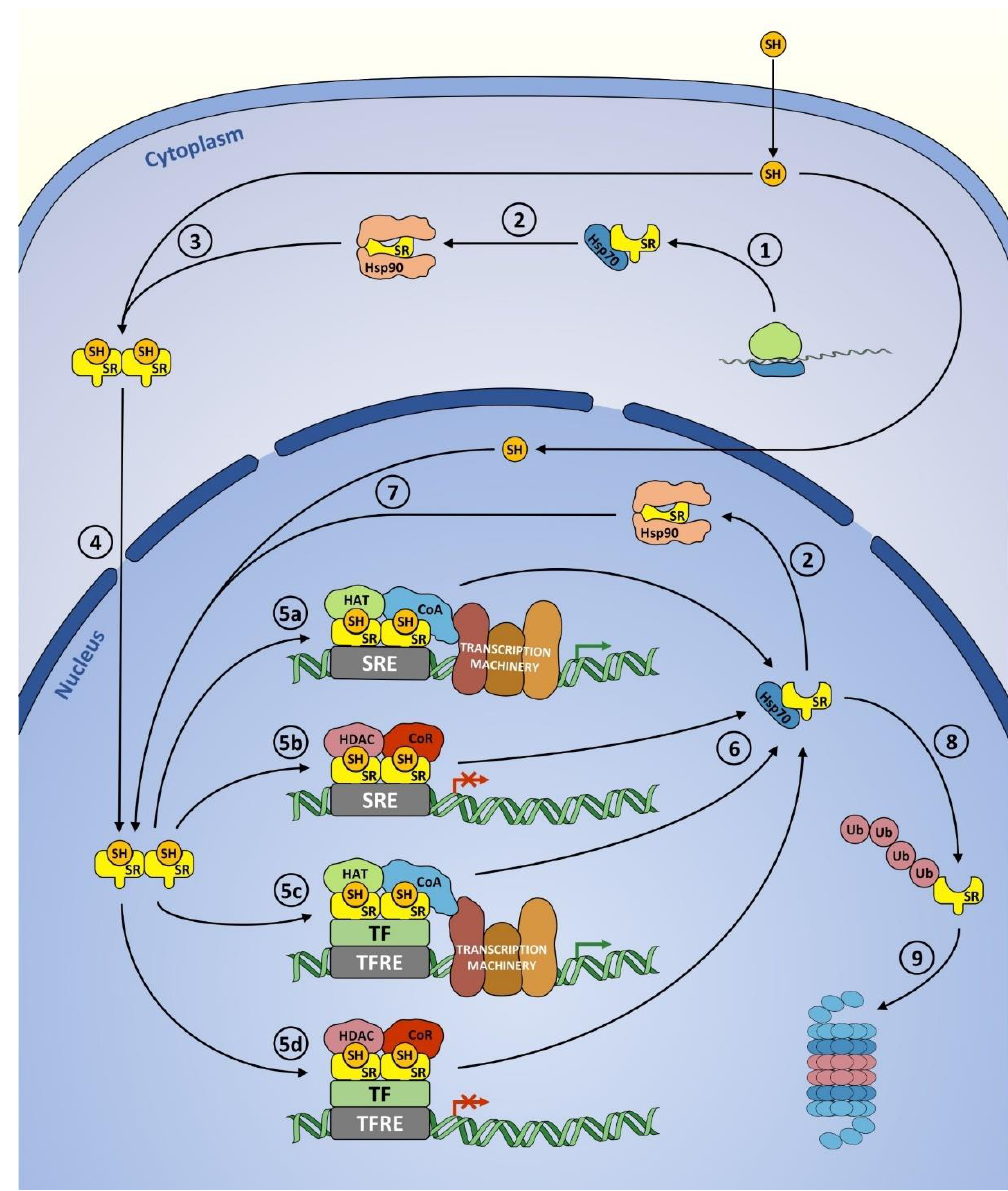
Figure 3. SR synthesis, genomic signaling and degradation. (1) Translation of a SR and binding of Hsp70. (2) Hsp70 to Hsp90 transition. (3) Ligand binding, Hsp90 dissociation and dimerization. (4) Nuclear translocation. (5) Transcriptional action: induction (5a, 5c) or inhibition (5b, 5d) of target gene expression, performed either in the classical mechanism involving SRE- binding (5a, 5b) or by tethering other TFs (5c, 5d). (6) Ligand dissociation followed by disassembly of the transcriptional complex and SR binding to a molecular chaperone. (7) Rebinding of the ligand. (8) Ubiquitination. (9)